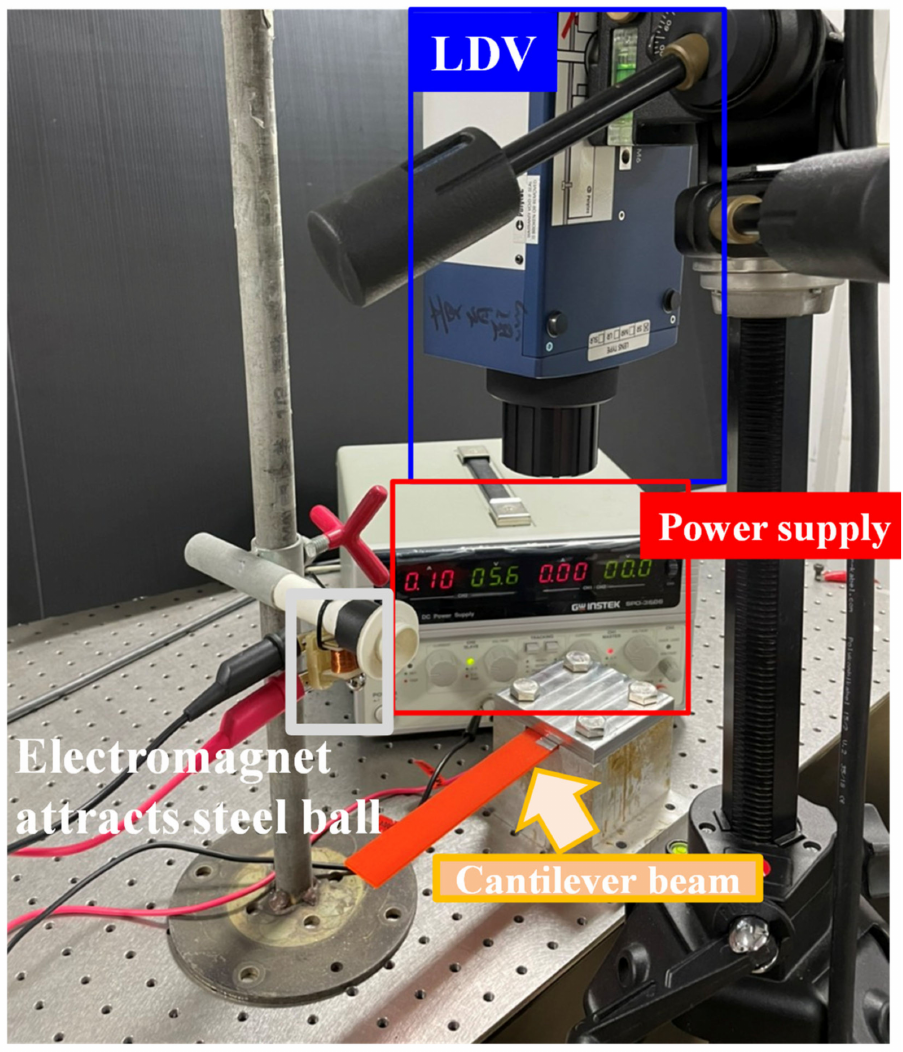
Figure 2. Setup of steel ball drop